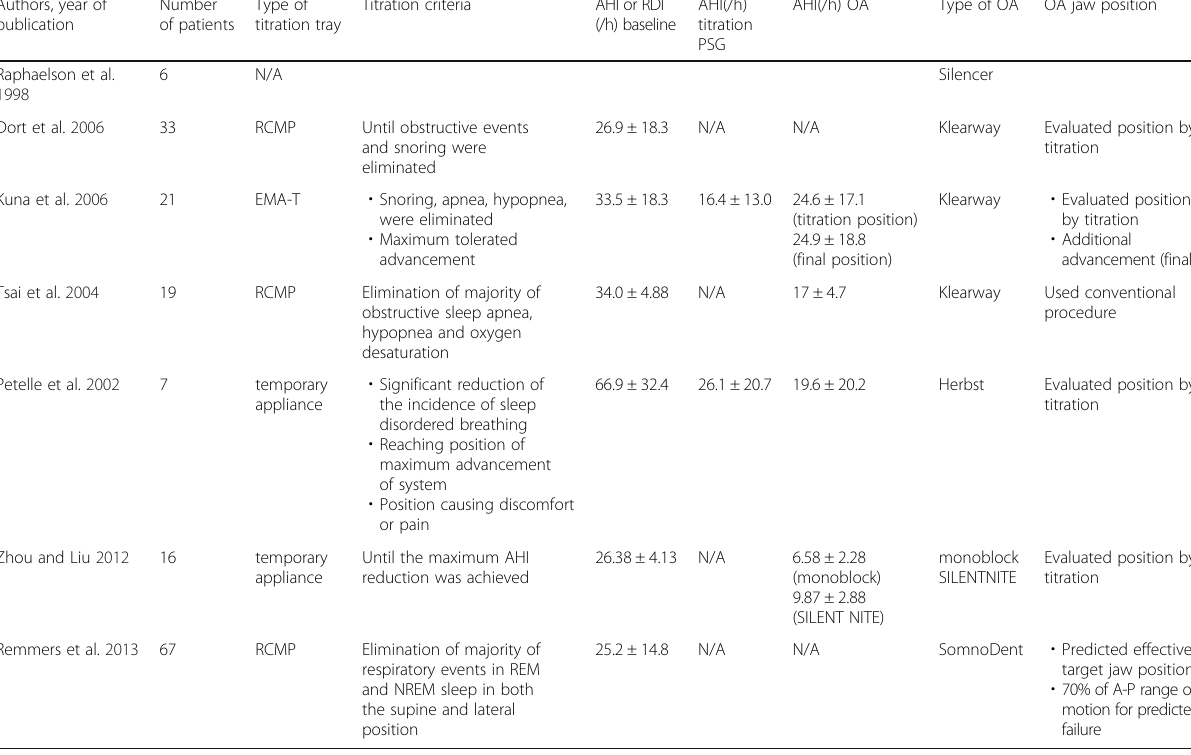
Table 1 Prediction of treatment response with oral